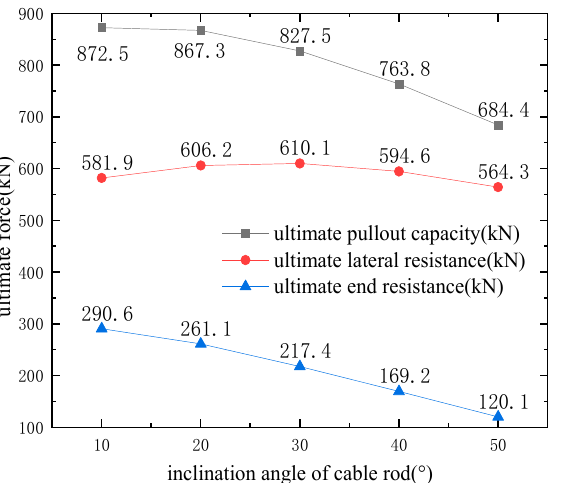
Figure 18. The ultimate force variation curves according to an increase in the inclination angle of the anchor cable.